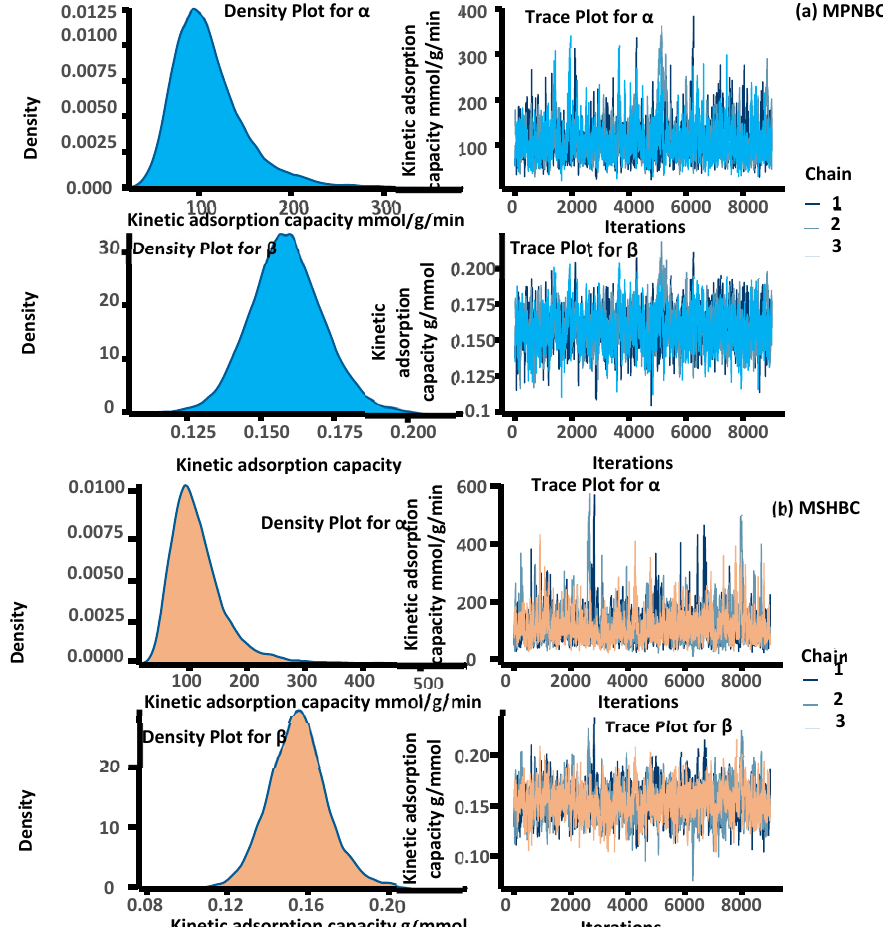
Fig. 4: The density and trace plots of Elovich kinetic model from the Markov chain Monte Carlo chain simulations for adsorption parameters convergence and peaks, demonstrating the application of Bayesian analysis of data